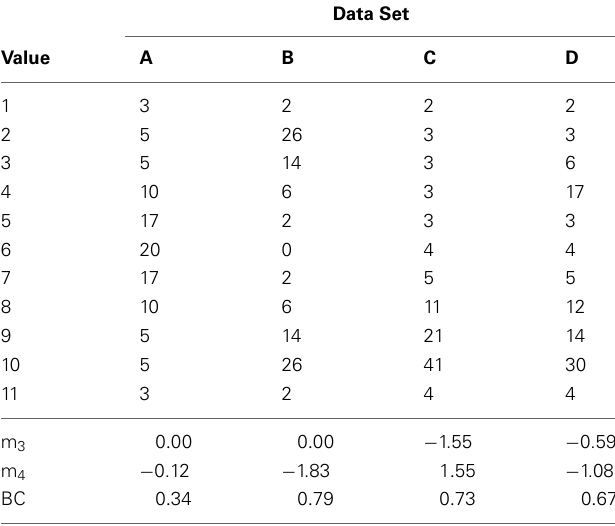
Table A1 | Frequency data of four hypothetical distributions of 100 values each, with corresponding estimates of skewness (m 3 ), kurtosis (m 4 ), and the